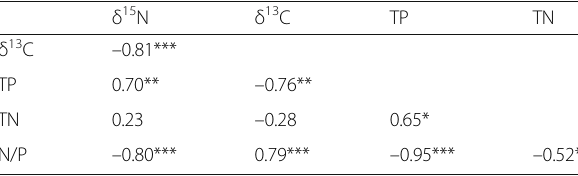
Table 3 Spearman rank correlation between stable isotope values and select environmental variables, N = 14